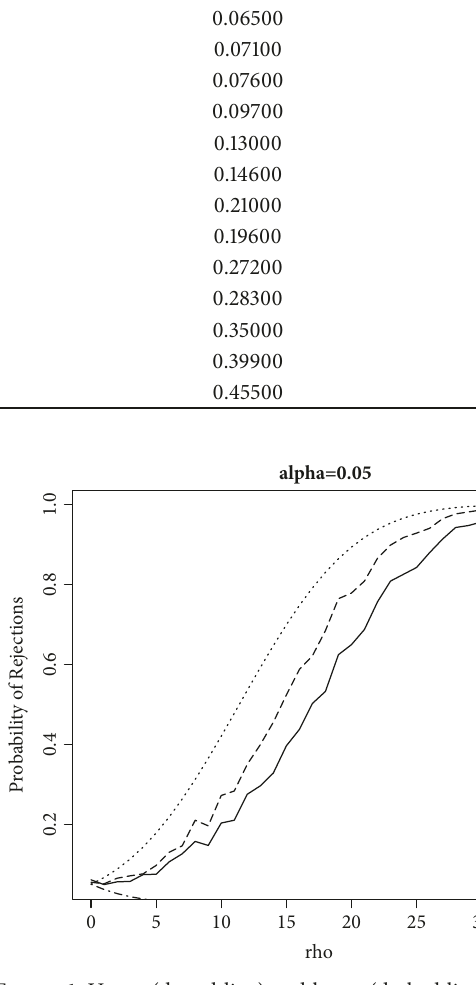
Figure 1: Upper (dotted line) and lower (dashed line) bounds for (̃𝑡 Ψ ,𝜑 ) (solid line), with 𝛼 = 0.05 Z 0 𝑝 Z 0 𝑝 f